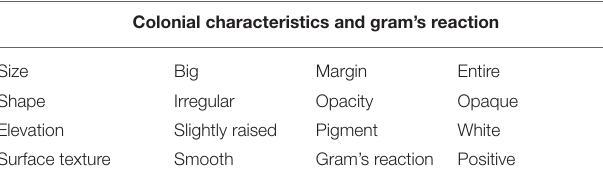
TABLE 1 | Colonial characteristics of Bacillus sp.